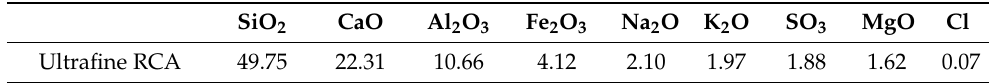
Table 3. Chemical composition (wt. %) of ultrafine